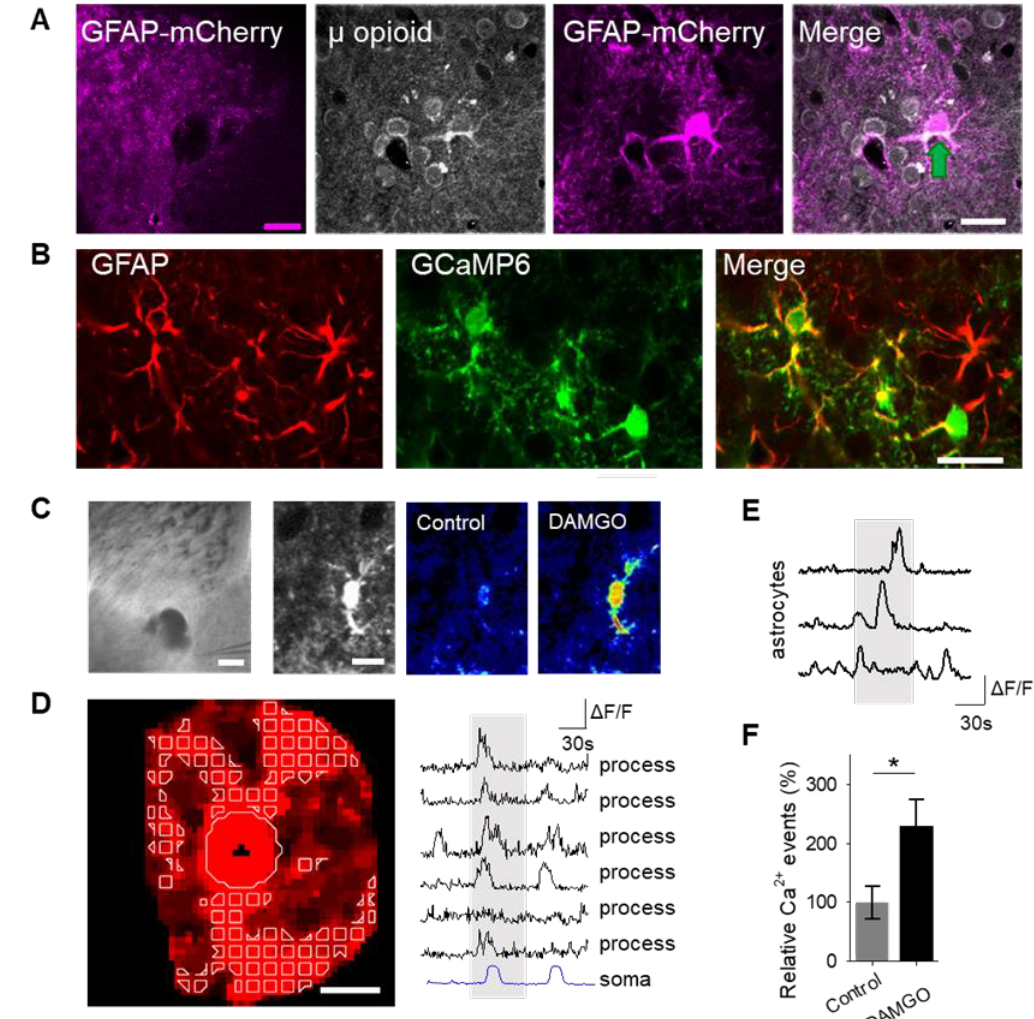
Figure 1. µ -Opioid receptor activation increases astrocyte cytoplasmic calcium levels. ( A ) Immunohistochemical images of µ -opioid receptor expression in mCherry-expressing astrocytes and the merged image in the nucleus accumbens. Scale bar: magenta = 200 µ m; white = 20 µ m. Green arrow indicates colocalization. ( B ) Immunohistochemical images of GCaMP6 expression in Glial fibrillary acidic protein (GFAP)-expressing cells in the nucleus accumbens. Scale bar = 20 µ m. ( C ) Image (scale bar = 200 µ m) illustrating experimental approach of locally targeting DAMGO ([D-Ala 2 , NMe-Phe 4 , Gly-ol 5 ]-enkephalin) to the nucleus accumbens, and pseudocolor images (scale bar = 10 µ m) showing the fluorescence intensities of a GCaMP6-expressing astrocytes before and after DAMGO application in the nucleus accumbens. ( D ) Representative image of the soma and process regions of interests (sale bar = 10 µ m), as well as calcium traces of nucleus accumbens astrocyte processes and the soma (gray shading indicates DAMGO application). ( E ) Calcium traces of astrocytes (gray shading indicates DAMGO application). ( F ) Relative calcium events before (control) and after DAMGO application. Data are expressed as mean ± standard error of the mean (SEM), * p < 0.05.